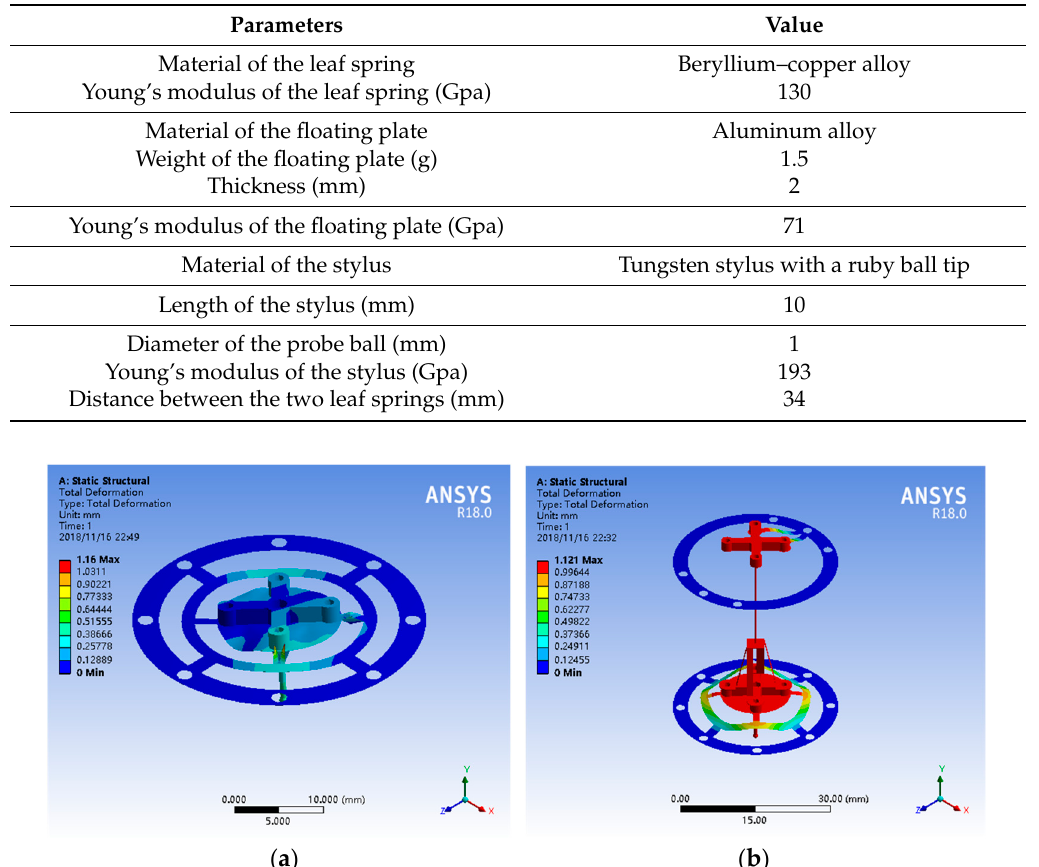
Figure 4. Dimensions of the leaf spring 1 ( left ), leaf spring 2 ( middle ) and the floating plate 1 and 2 ( right ), (unit: mm). Table 1. Parameters of the probe.